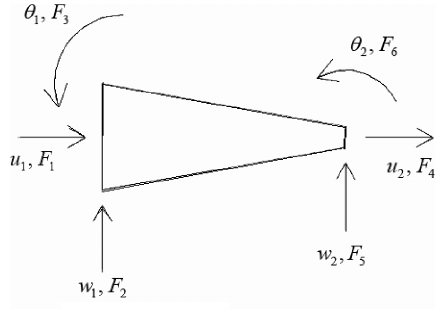
Fig. 1. Positive sign convention for nodal degrees of freedom and